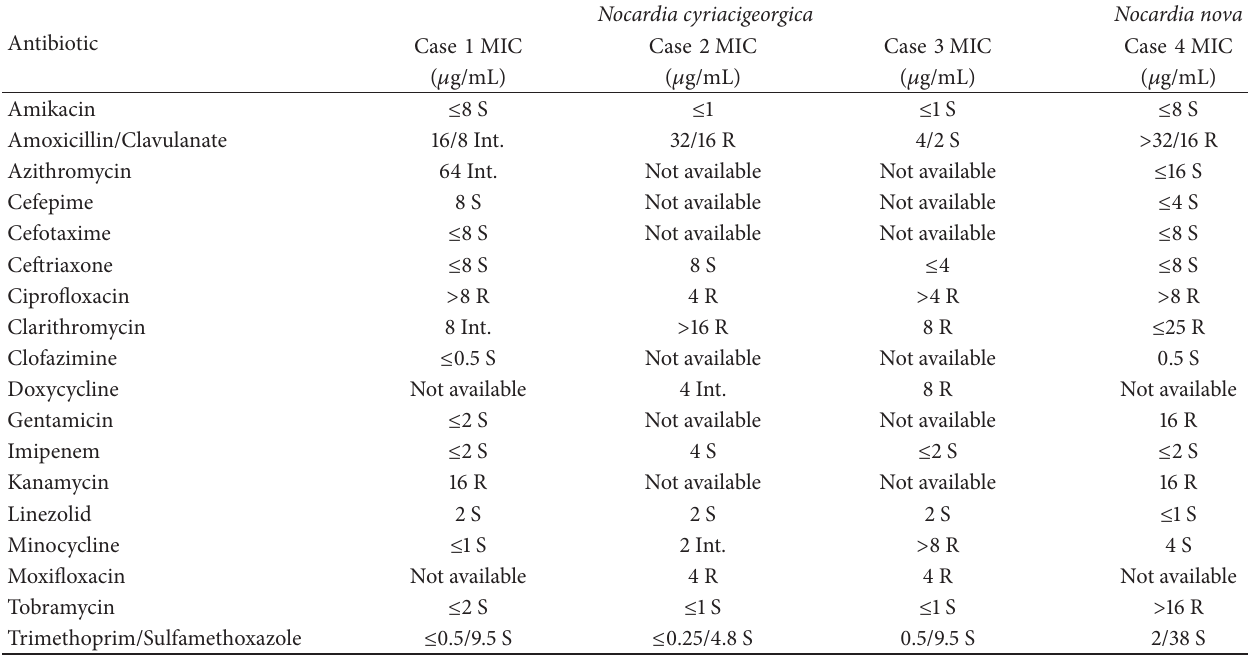
Table 1: Antimicrobial susceptibilities of Nocardia species isolated from sputum cultures.